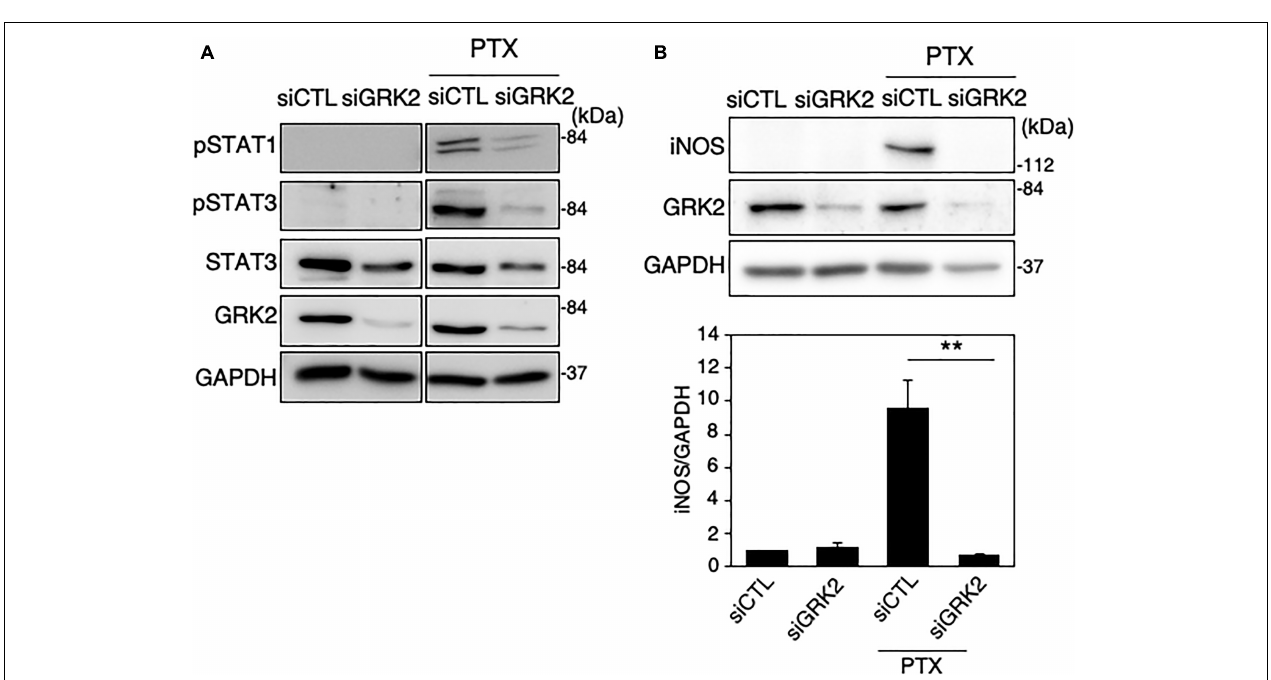
FIGURE 7 | Effect of GRK2 siRNA transfection on paclitaxel-induced TLR4 signaling for iNOS expression in MG6 cells. (A) Phospho-STAT1 at Tyr-701, phospho-STAT3 at Tyr-705, and total STAT-3 before and 6 h after 10 µ M paclitaxel (PTX) application in the presence of GRK2 siRNAs (siGRK2) or the negative control siRNAs (siCTL). Transfection of siGRK2, but not of siCTL, effectively decreased GRK2 protein expression, and GAPDH was used as loading control. Shown are representative Western blots from three independent experiments in which the same results were obtained. (B) Effect of siGRK2 transfection on iNOS protein expression 12 h after 5 µ M paclitaxel application. The results represent the mean ± SEM for three independent experiments. ∗∗ P < 0.01 by t -test. In the upper side, typical Western blots are shown. GAPDH served as loading control.